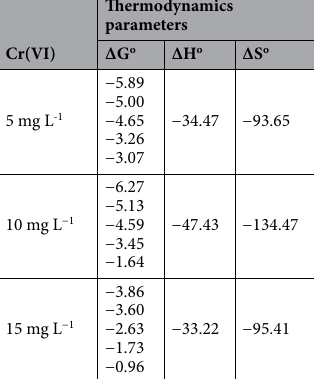
Table 3. Thermodynamic parameters.